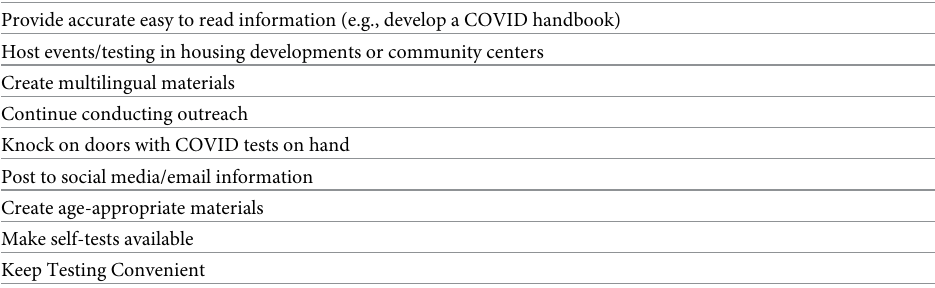
Table 1. Resident suggestions for increasing acceptability and uptake of SARS CoV-2